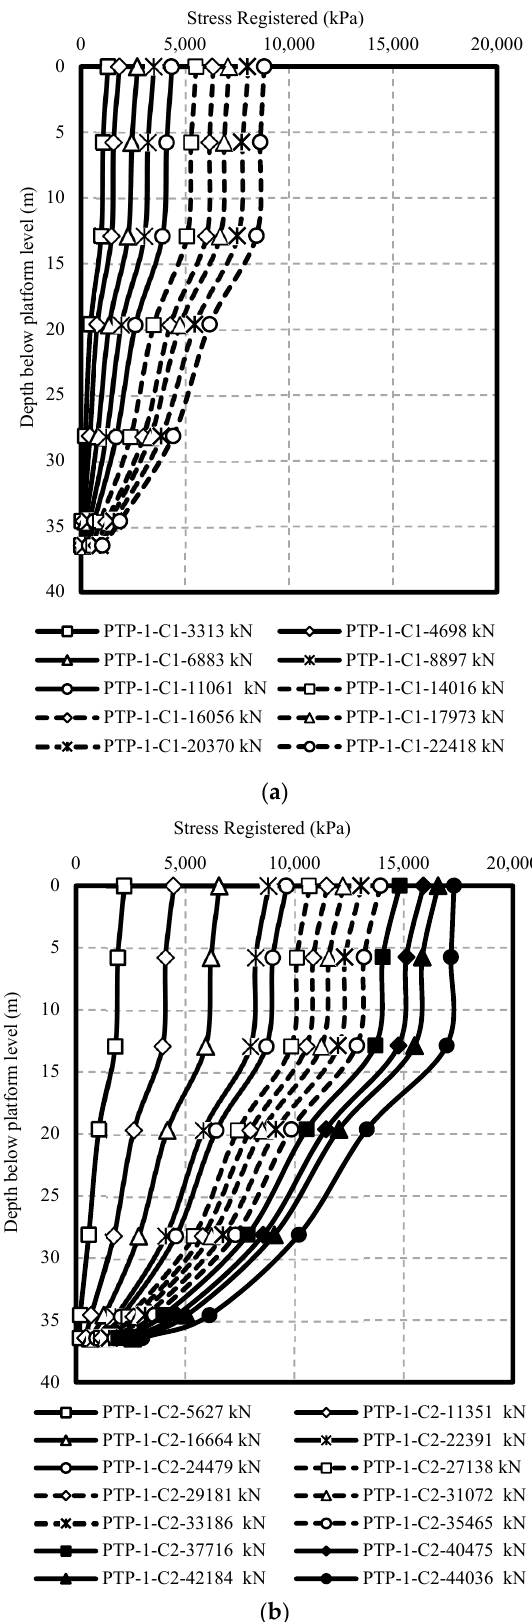
Figure 11. Stress distribution measured along BP# 1 in ( a ) 1st cycle and ( b ) 2nd cycle.